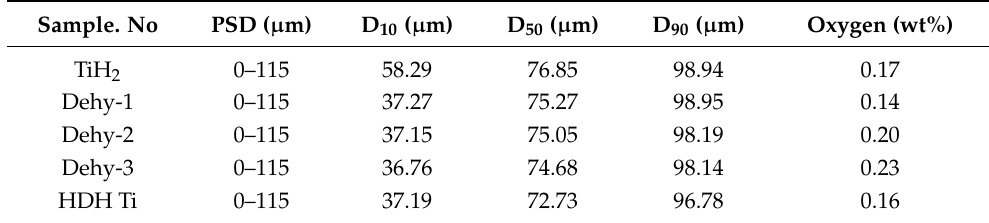
Table 2. Particle size distribution and oxygen content of TiH 2 , Dehy-1, Dehy-2, Dehy-3 and HDH Ti